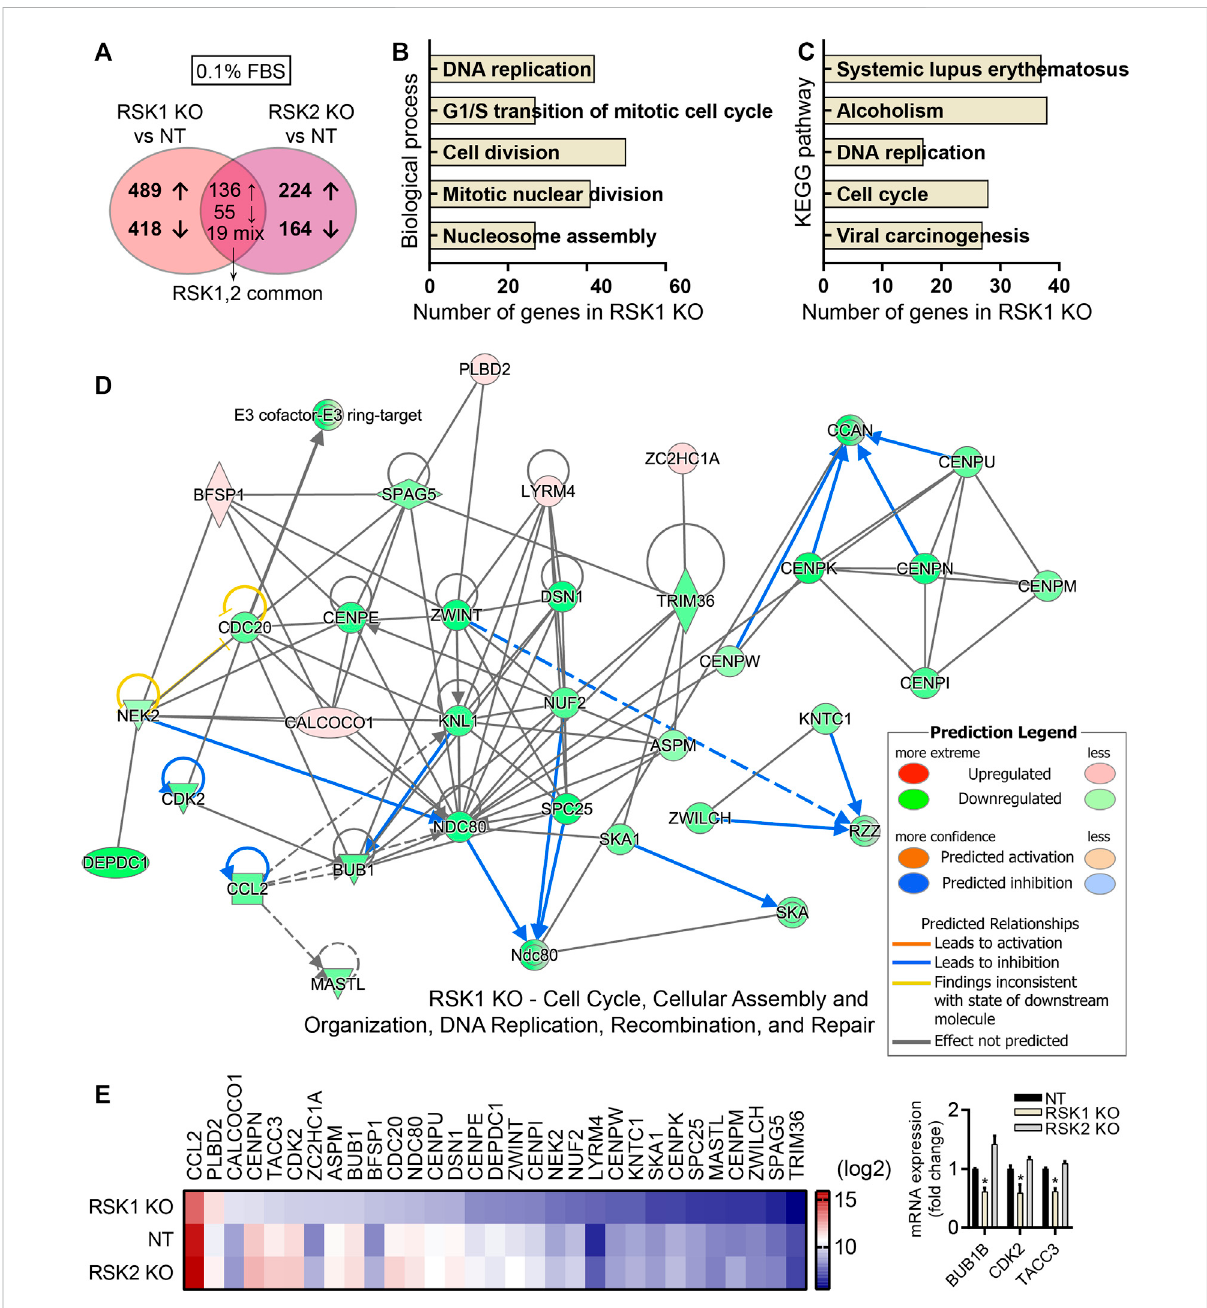
FIGURE 5 PathwayanalysisofRSK1KODEGsin0.1%FBScondition. (A) VenndiagramillustrationofthenumbersofDEGsspeci fi ctoRSK1KOandRSK2KO, plus overlapping genes common to both RSK1 KO and RSK2 KO (fold change < -2 or > 2; p < 0.05). (B) Top fi ve biological processes analyzed from RSK1 KO-speci fi c DEGs. (C) Top fi ve KEGG pathways analyzed from RSK1 KO-speci fi c DEGs. (D) Gene network for ‘ Cell cycle, Cellular Assembly and Organization, DNA Replication, Recombination, and Repair ’ from RSK1 KO-speci fi c DEGs in 0.1% FBS. (E) Heat map analysis of thirty DEGs highlighted from top networks as shown in (D) . Increased (red) or decreased (blue) gene color intensity indicates a corresponding increased or decreased signal intensity, as annotated in the scale. mRNA expression of BUB1B, CDK2 and TACC3 genes were used to validate microarray analysis (right). *, p <